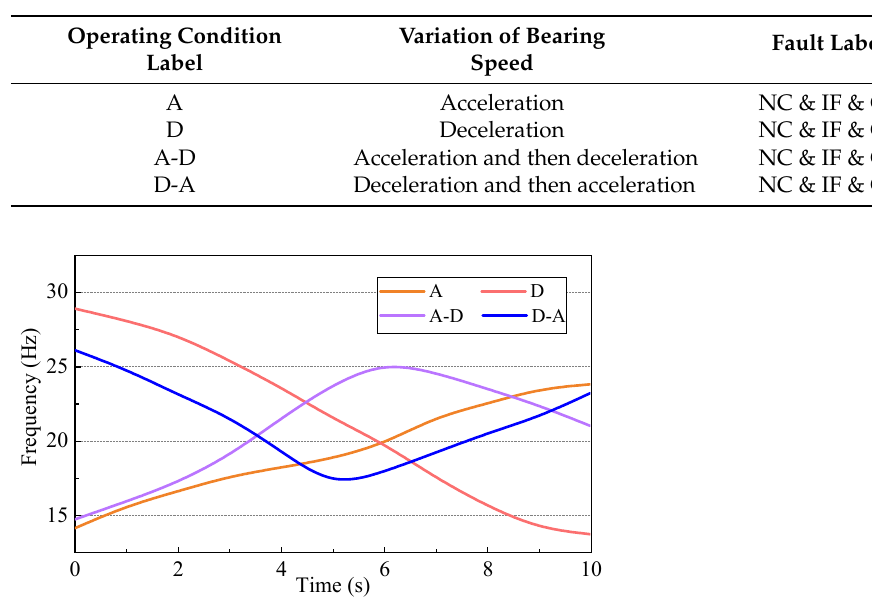
Table 4. Division of the University of Ottawa dataset.